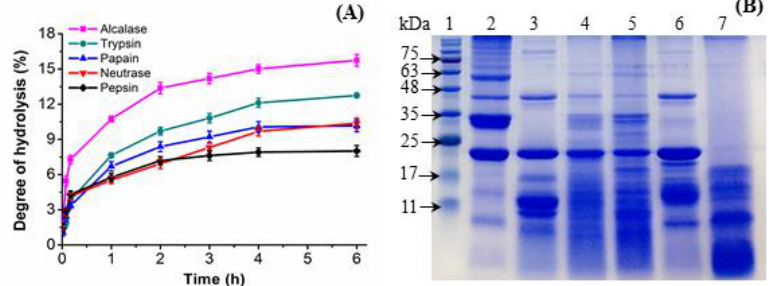
Figure 1. ( A ) Degree of hydrolysis of P. ostii seed meal protein ( Po SMP) by five different proteases. ( B ) Sodium dodecyl sulphate polyacrylamide gel electrophoresis (SDS-PAGE) of Po SMP and five peptidase hydrolysates. Lane 1: Marker (protein standard); lane 2: Po SMP; lane 3: AHs (alcalase hydrolysates); lane 4: THs (trypsin hydrolysates); lane 5: PaHs (papin hydrolysates); lane 6: NHs (neutrase hydrolysates); lane 7: PeHs (pepsin hydrolysates).